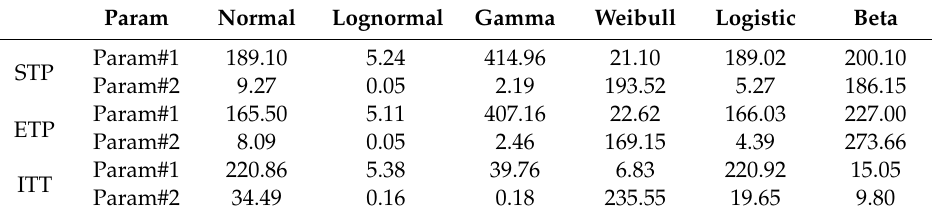
Table 3. Parameters of six reference distributions.